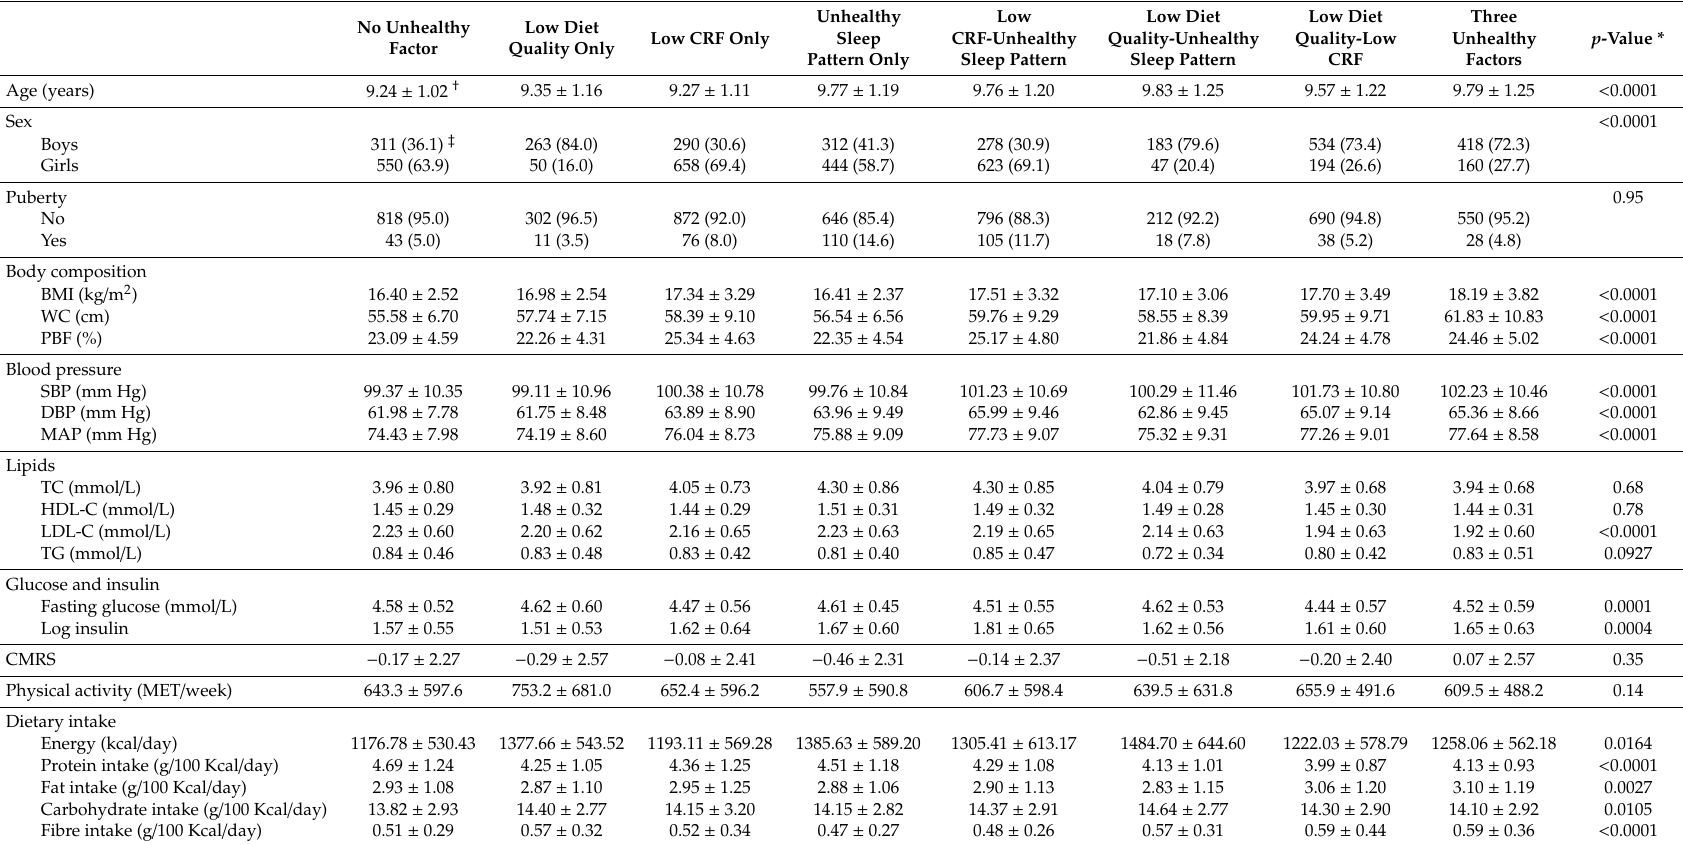
Table 1. Baseline characteristics by a combination of three unhealthy